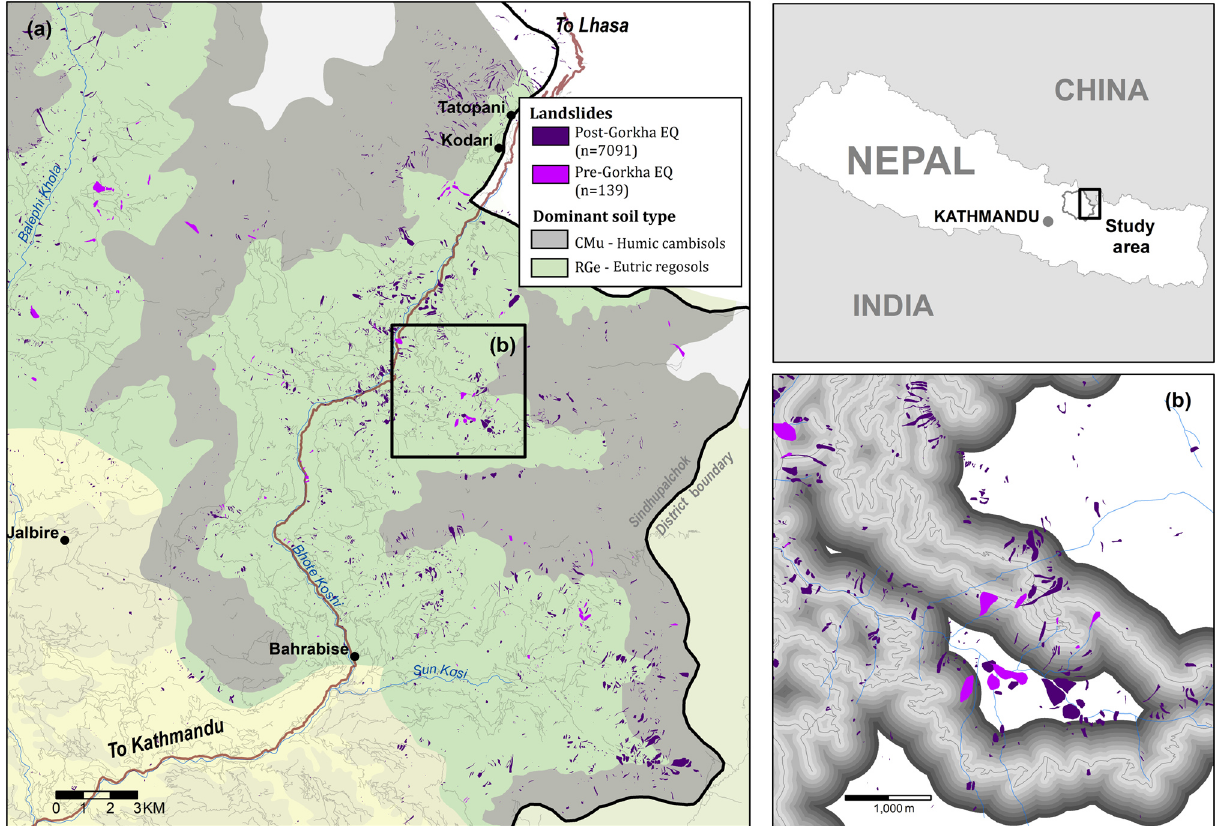
Figure 3. Roads and landslides in Sindhupalchok District, Nepal. (a) The Arniko Highway that runs between Kathmandu and Kodari at the Chinese border was heavily impacted by the 2015 Gorkha earthquake, and a dense network of informal, rural roads grows out of this main trunk road (OpenStreetMap Contributors, 2017). The dark purple polygons mark the location of landslides generated during the earthquake, and the light purple polygons were the landslides that were present before the earthquake (2014). Most landslides correspond with the RGe (Eutric Regosols) soil type as mapped by Dijkshoorn and Huting (2009). However, there is a higher percentage of earthquake-generated failures in the Humic Cambisols (CMu) soils. (b) We place buffers at 50m intervals along the roads in the study area that can support a vehicle to determine the distribution of landslides that correlate spatially with the